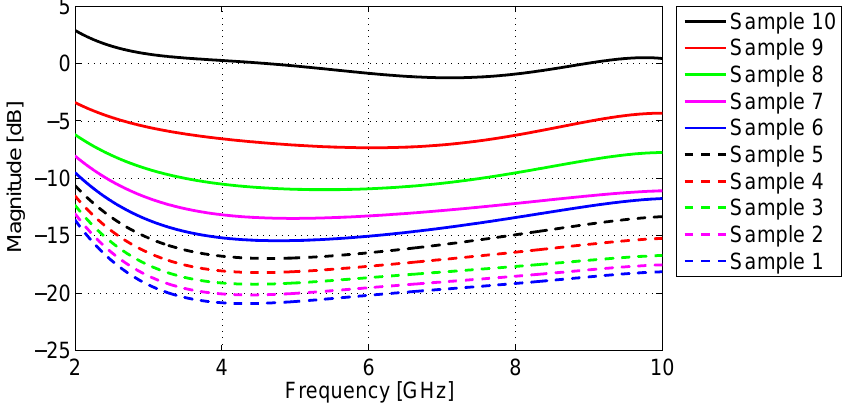
Figure 5. Magnitudes of the computed antenna responses for each tissue